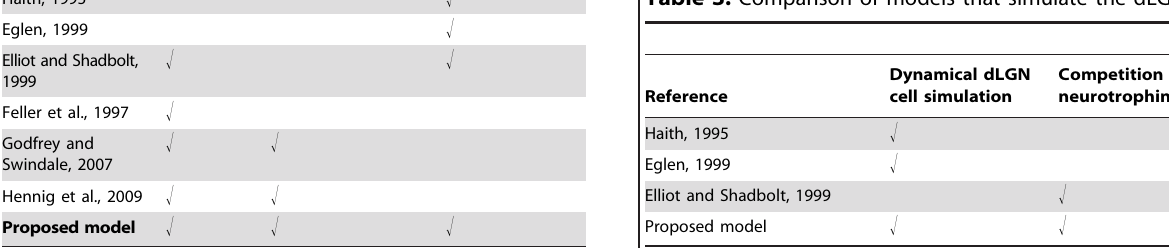
Table 3. Comparison of models that simulate the